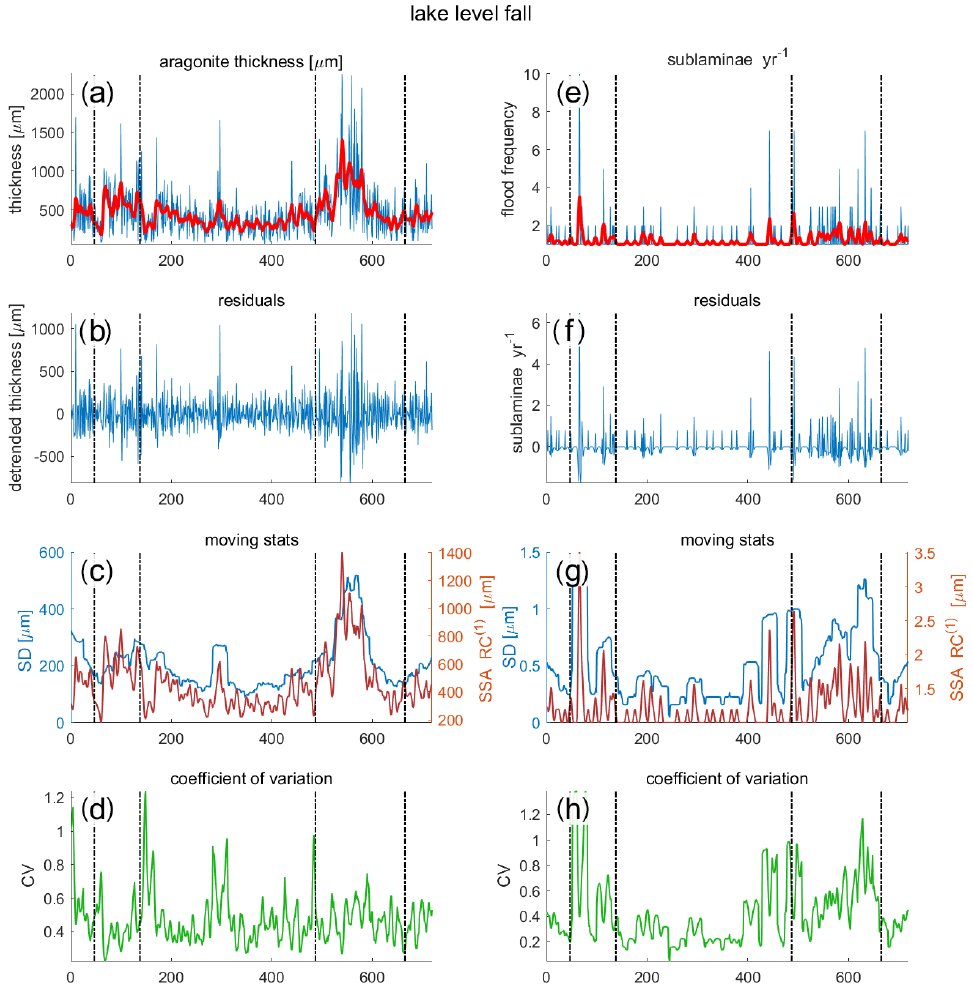
Figure 10. Running statistical properties of aragonite lamina thickness (a–d) and flood frequency (e–h) for the studied lake-level fall. The measured data (a, e) , the residuals (after subtracting the RC (1) ) (b, f) , RC (1) and running standard deviation (30-year window) (c, g) , and the (d, h) coefficient of variation calculated as running SD RC (1)